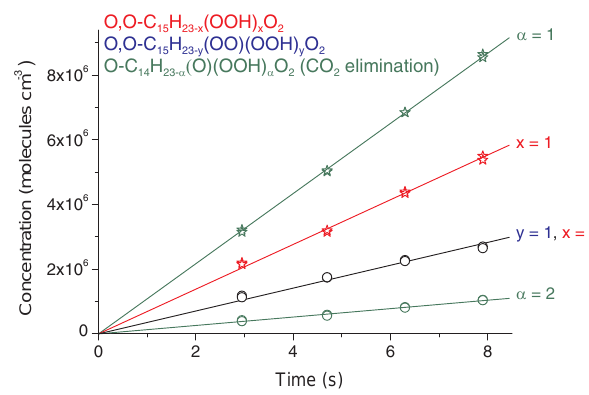
Figure 10. Time dependence of highly oxidized RO 2 radical formation from the ozonolysis of β -caryophyllene using ac- etate ionization, data from the simple AutOx. group with O,O– C 15 H 23 − x (OOH) x O 2 with x = 1 and 2 (in red), from ext. Au- tOx. with O,O–C 15 H 23 − y (OO)(OOH) y O 2 with y = 1 (in blue) and from ext. AutOx. -CO 2 with O–C 14 H 23 − α (O)(OOH) α O 2 with α = 1 and 2 (in green). The black-coloured data points (open cir- cles) stand for the sum of the RO 2 radical from the simple Au- tOx. group, O,O–C 15 H 23 − x (OOH) x O 2 with x = 2 and from the ext. AutOx. group, O,O–C 15 H 23 − y (OO)(OOH) y O 2 with y = 1. [ β -caryophyllene] = 8 . 6 × 10 10 , [O 3 ] = 3 . 1 × 10 11 moleculescm − 3 , reaction time is